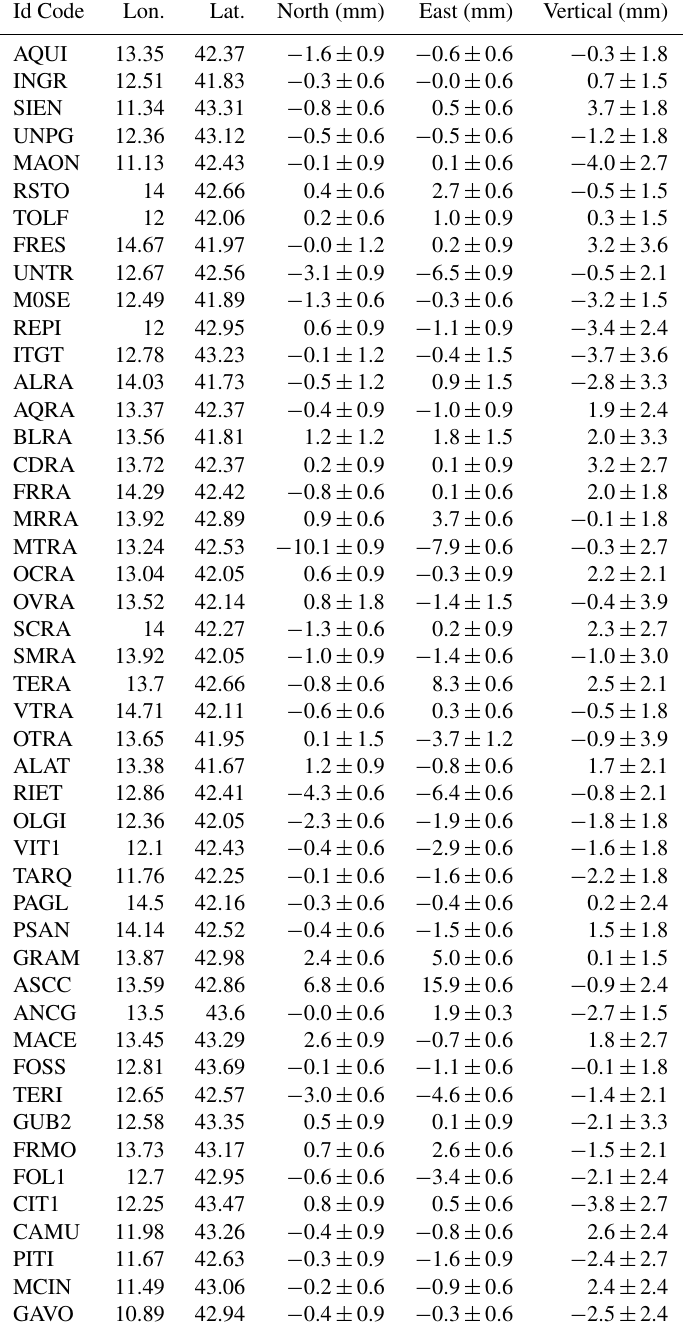
Table A1. Coseismic displacements determined for the GPS stations lying within 100km from the epicenter of the 24 August main shock. The GPS code of the CGPS site is reported on the first column, the geographical coordinate (Lon = Longitude and Lat = Latitude) are reported in the second and third column. Dn, De and Dv are respectively the coseismic anelastic displacement along the North, East and Vertical direction. The uncertainties associated to the coseismic displacements have been estimated by a Weight Least Square Method adopted to evaluate velocity, discontinuities due to earthquakes and/or equipment changing and seasonal signals, as discussed briefly in the text (Cenni et al., 2012,